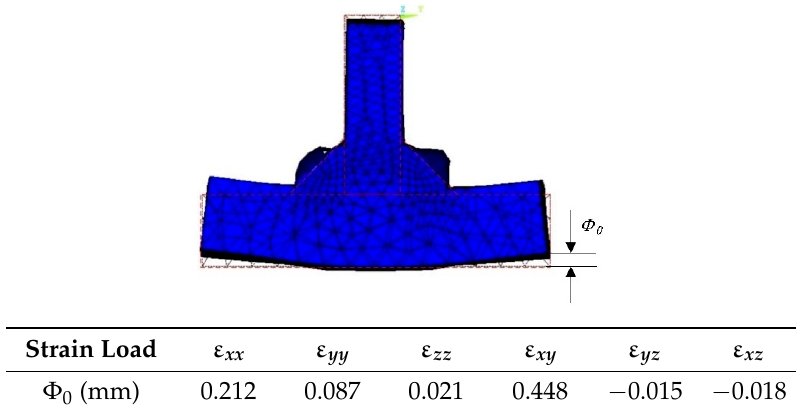
Figure 6. Angular distortion under different stain loads.